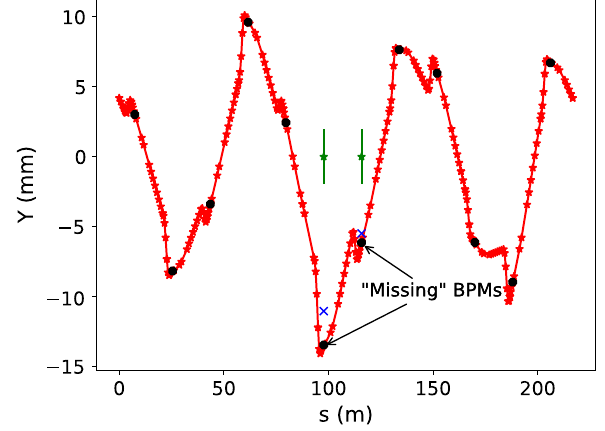
FIG. 9. Prediction of the closed orbit position at the missing BPM locations. Red (star): Simulated perturbed orbit in MAD - X in the y plane of SIS18. Black (circle): Sampling of perturbed orbit at BPM locations. Green (star): Random initial guess for the orbit position at the two missing BPM locations. Blue (times): Estimated orbit position at missing BPM locations using the DFT mode structure of the SIS18. A misaligned quadrupole has the effect of a magnetic dipole on the beam, and as a result the closed orbit is perturbed from its “ ideal path. ” The black dots in Fig. 9 represent the sampling of the perturbed orbit at the locations of BPMs, while the green dots show the mean values of random orbit positions (in a range of − 1 to 1 mm marked as error bars around the green dots) assumed at the location of missing or faulty BPMs. A combination of cosine functions with discrete frequencies f ¼ 3 , 4, 2, 5 (corresponding to dominant Fourier modes) was used to estimate the orbit position at the missing BPM locations, keeping their relative amplitudes and phases as free parameters to be optimized. The fitting algorithm was constrained to keep the fitted curve closest to the orbit positions within an accuracy of 0.01 mm at the working BPM locations while free to choose any value at the location of missing BPMs. As a result, the optimized orbit positions are found to be closer to the actual orbit positions within maximum errors of 3 (cid:5) 0 . 048 and 0 . 5 (cid:5) 0 . 048 mm, respectively. Figure 10 shows the simulated orbit correction using the estimated orbit positions (green curve). The red curve shows the perturbed orbit without corrections, while the magenta curve shows the corrected orbit when all BPMs are working. The orbit correction using SVD of the noncirculant matrix (excluding the rows in the ORM corresponding to the faulty BPMs) is plotted in black. The orbit correction taking the orbit position “ zero ” at the missing BPM locations and using a circulant matrix is also plotted as a blue curve for comparison. The robustness against missing BPMs is shown by the overall improved correction obtained using an estimated beam position instead of using the noncirculant matrix. Besides the better global correction, one can also get the benefits of circulant